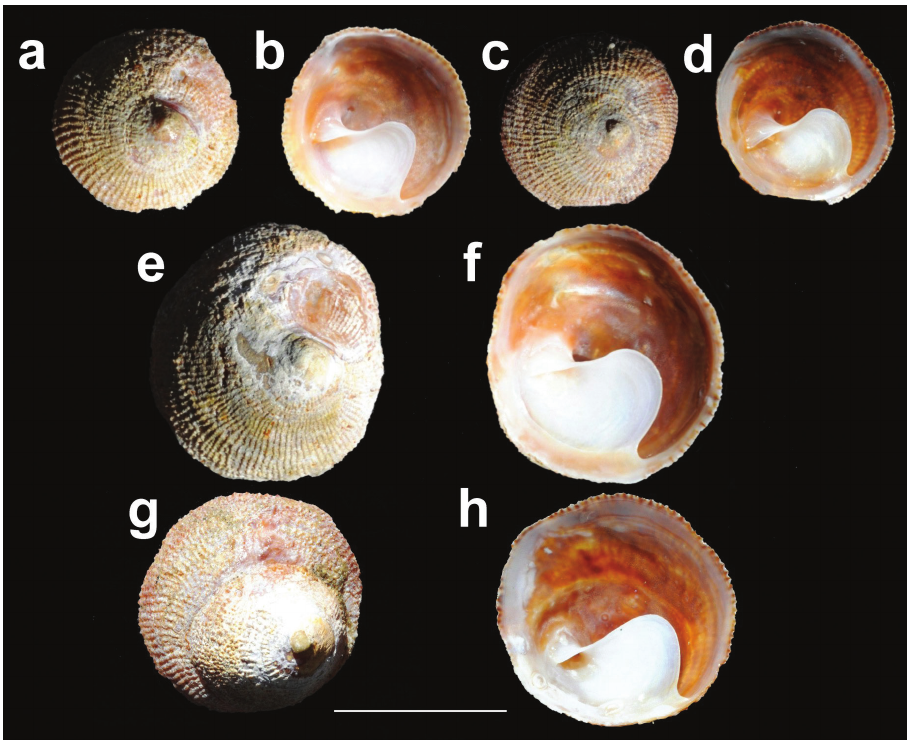
Figure 5. Shells of Calyptraea aurita . a IZUA-UACH Mg 501 dorsal view b , ventral view c IZUA- UACH Mg 505 dorsal view d ventral view e IZUA-UACH Mg 502 dorsal view f ventral view g IZUA- UACH Mg 504 dorsal view h ventral view. Scale bar: 2